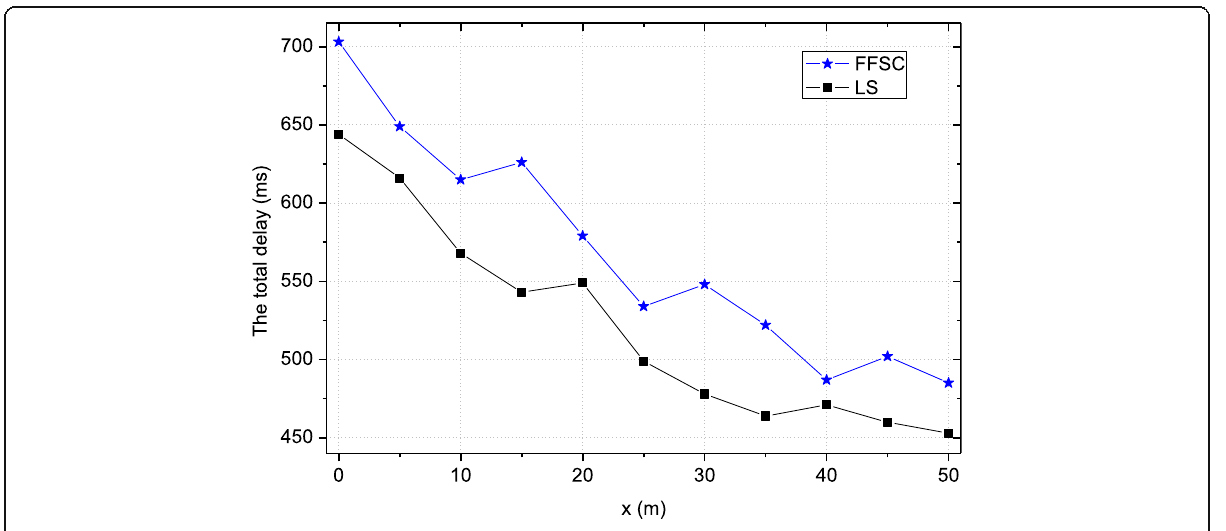
synchronization is achieved in the self-learning period, the energy consumption during the transmission is ef- fectively reduced. Thus, the bell-shaped is formed in Fig. 14. And the trends of curves in Figs. 14 and 15 prove that the closer the distance between a node and sink, the